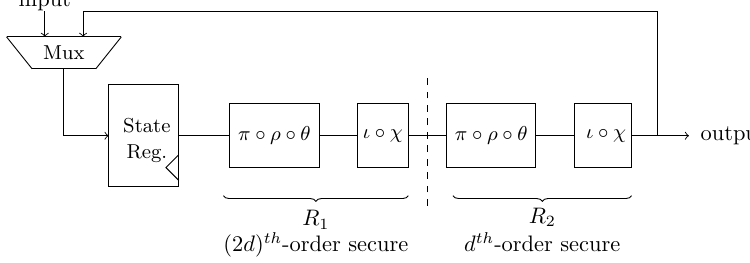
Figure 2: Two-rounds unrolled architecture of